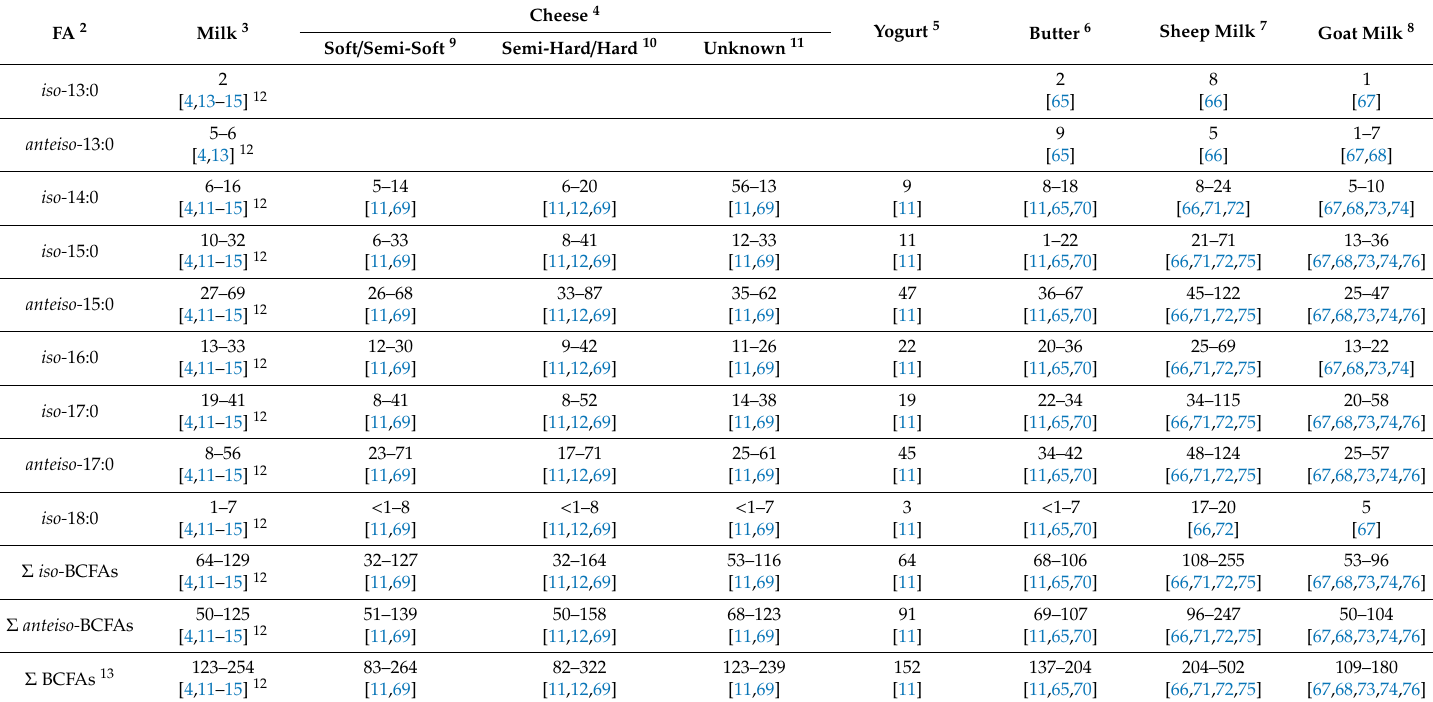
Table 2. Branched-chain fatty acid content (mg / serving) of common dairy products 1